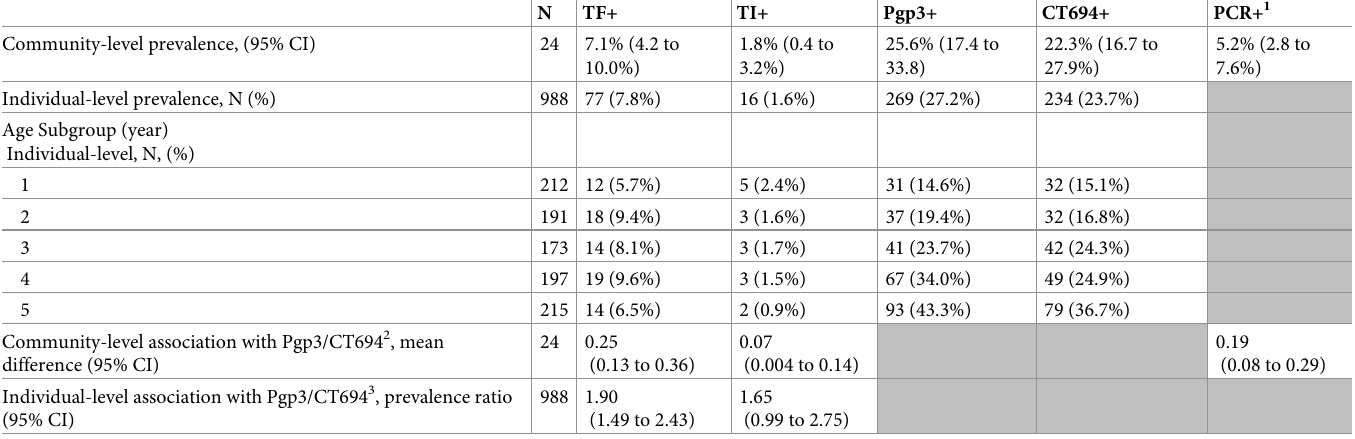
Table 1. Community and individual-level trachoma indicators, overall and by age group.